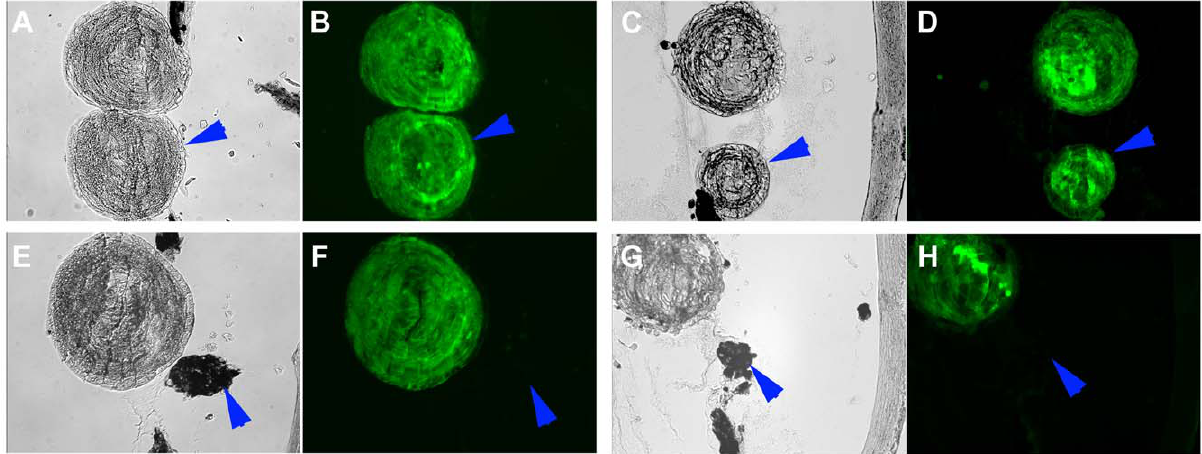
Figure 2. Gain of function. Effects of miR-148 and let-7b up-regulation on the capability of dorsal and ventral PECs to transdifferentiate to lens. Cells were transfected as described in methods and after they were aggregated they were implanted in lentectomized eyes. The eyes were examined 30 days later. A, B: dorsal PECs and E, F: ventral PECs, transfected with miR-148. C, D: dorsal PECs and G, H: ventral PECs transfected with let-7b. Note that only dorsal aggregates differentiated to lens (left panels are phase contrast and left panels stained with a crystallin antibody). Arrowheads indicate the induced lens from the dorsal aggregates or the un-induced ventral PECs aggregate. doi:10.1371/journal.pone.0012058.g002 PLoS ONE |